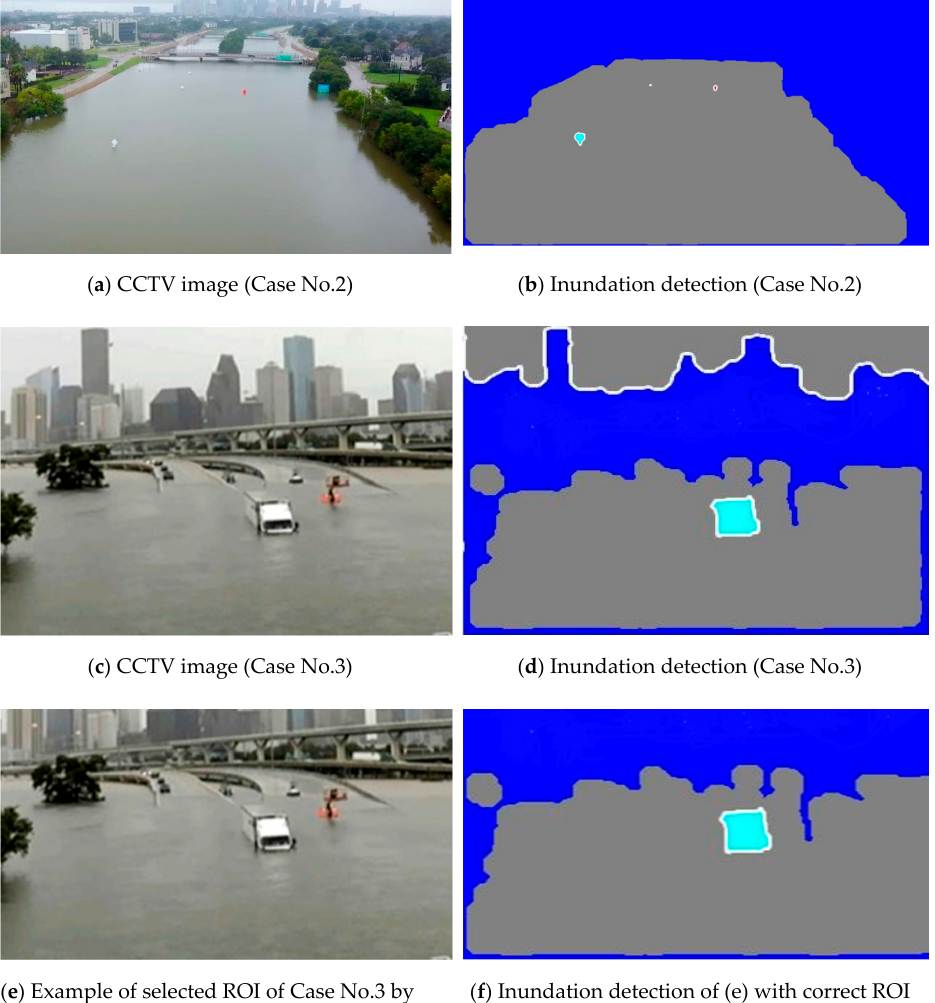
Figure 9. Inundation detection based on the results of Bayesian segmentation. To avoid detection errors, the region of interest (ROI) should be chosen carefully; cutting off the sky part of the CCTV image (Case No.3) allows for providing the correct ROI for accurate inundation detection.